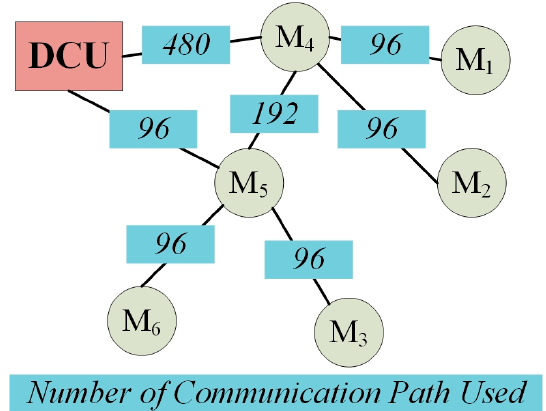
Figure 12. Number of Communication Paths Used for the Six-Meter Case.